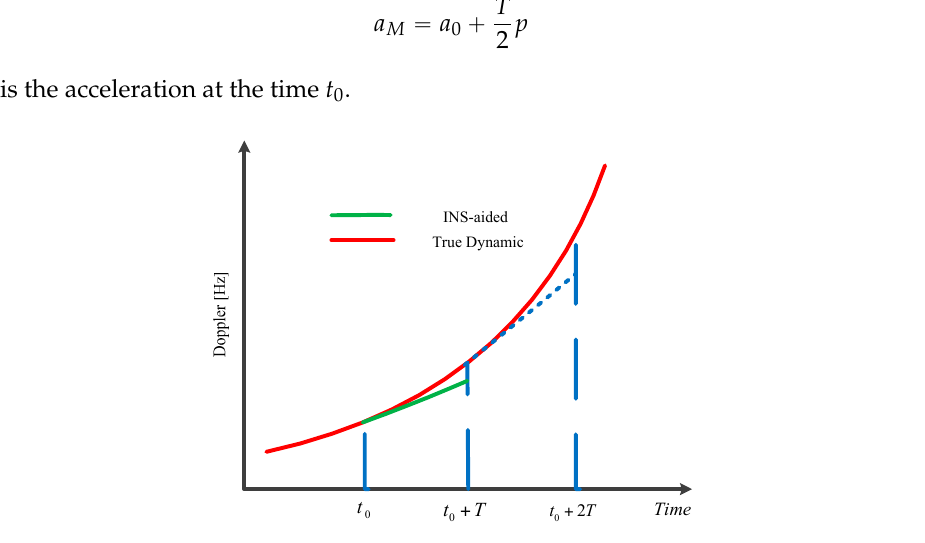
Figure 3. Aiding delay error with a jerk dynamic.